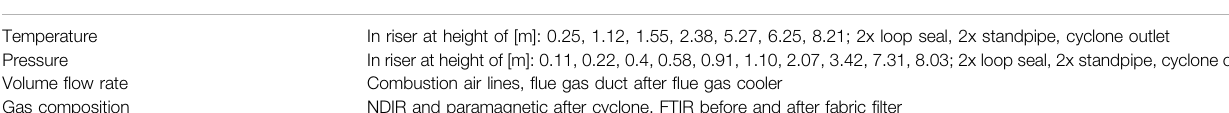
TABLE 1 | Measurement devices of the CFB pilot plant.